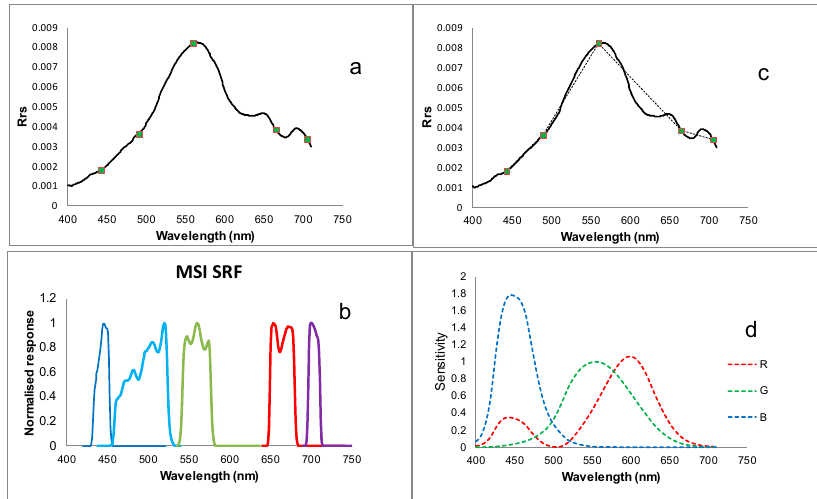
Figure 3. Original hyperspectral data plus green squares at the central positions of MSI bands ( a ); MSI measures the visual spectrum in only five wide bands ( b ); and the reconstructed spectrum will start to deviate from the original spectrum, especially at green and red wavelengths ( c , d ).